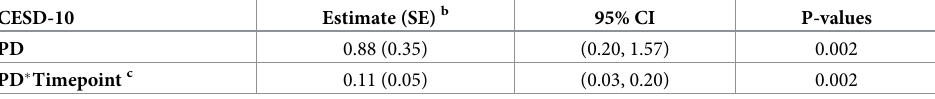
Table 2. Joint model estimates of the differences in CESD-10 score between a PD case and its expected value had the participant not developed PD a